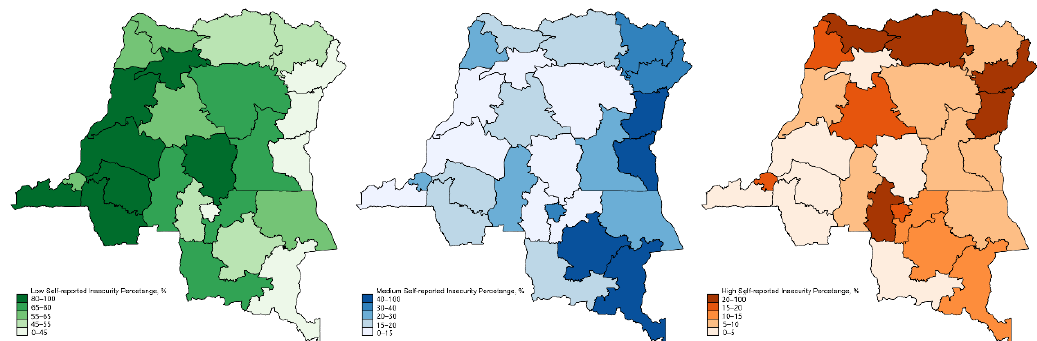
Figure 2. Distribution of different levels of self-reported insecurity in provinces of females in the DRC † . † Green: Low self-reported insecurity; Blue: Medium self-reported insecurity; Orange: High self-reported insecurity.